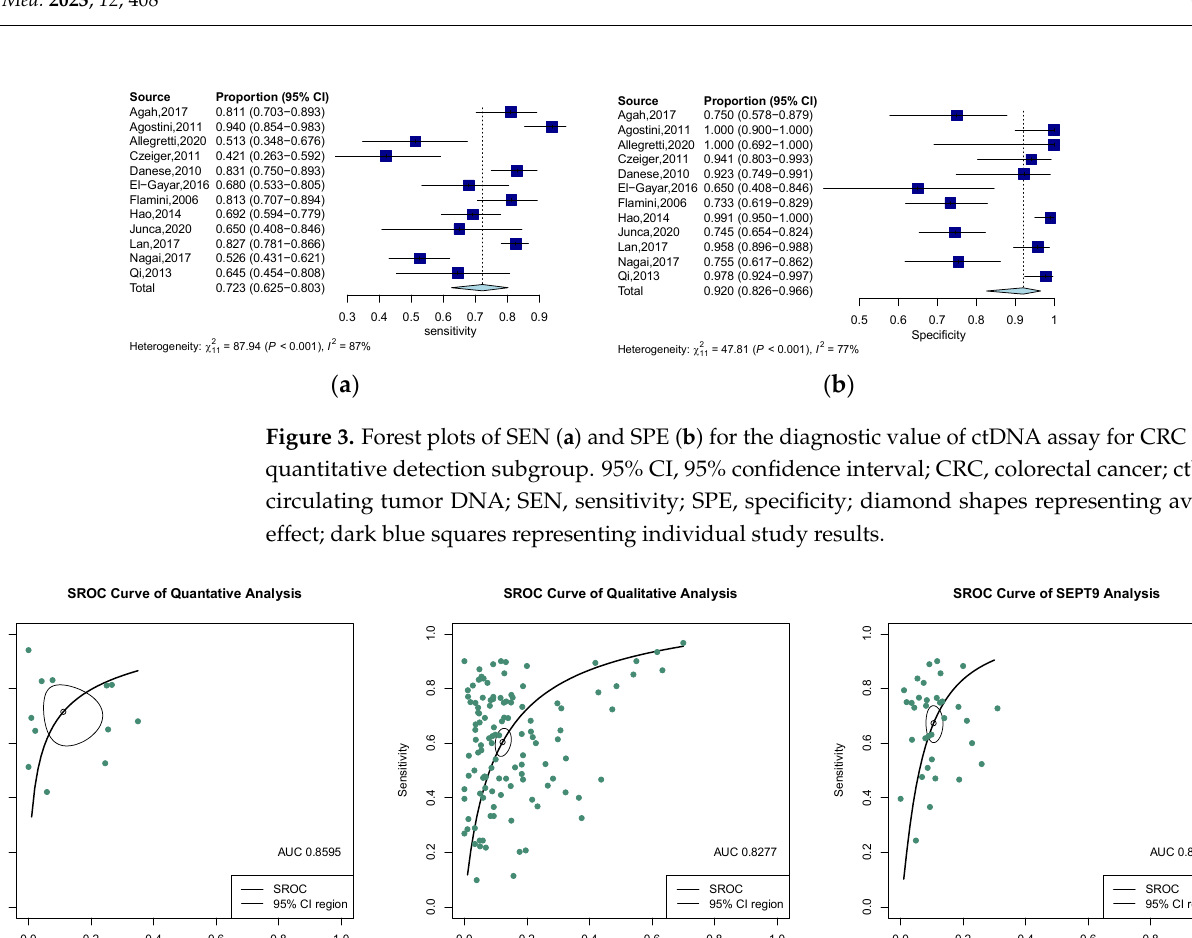
Figure 3. Forest plots of SEN ( a ) and SPE ( b ) for the diagnostic value of ctDNA assay for CRC in the quantitative detection subgroup. 95% CI, 95% confidence interval; CRC, colorectal cancer; ctDNA, circulating tumor DNA; SEN, sensitivity; SPE, specificity; diamond shapes representing average effect; dark blue squares representing individual study results.